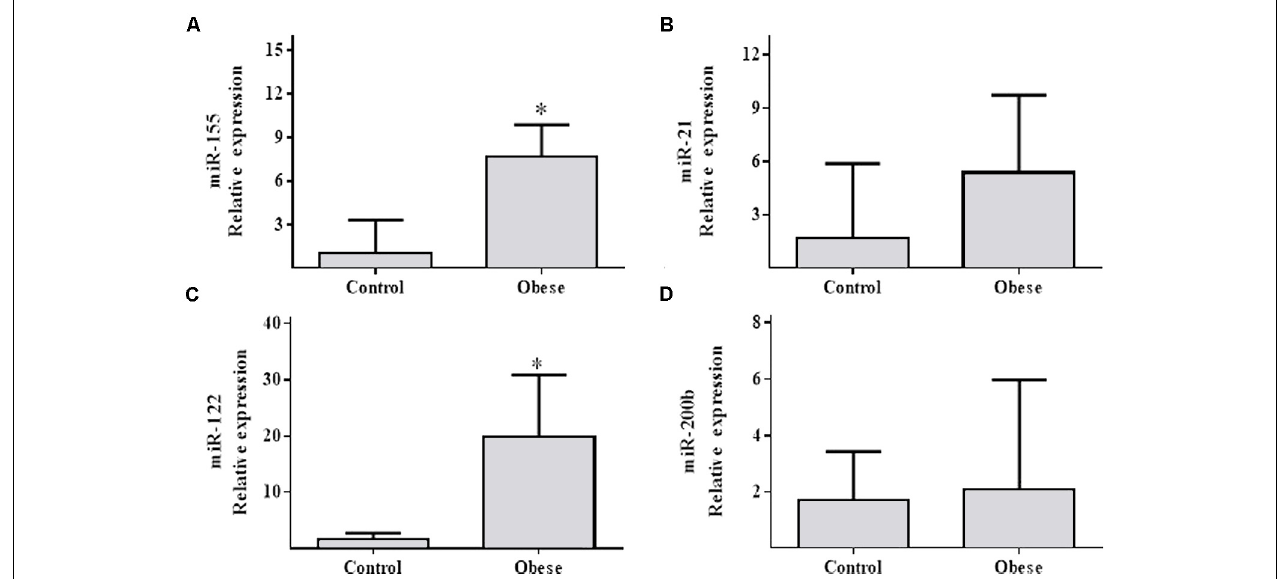
FIGURE 4 | Relative expression of miR-155, miR-21, miR-122 and miR-200b in the spermatozoa samples of obese subjects compared with the normal weight controls. (A) Differential relative miR-155 expression levels verified by qRT-PCR in the serum samples from normal weight ( n = 17) and obese ( n = 17) subjects